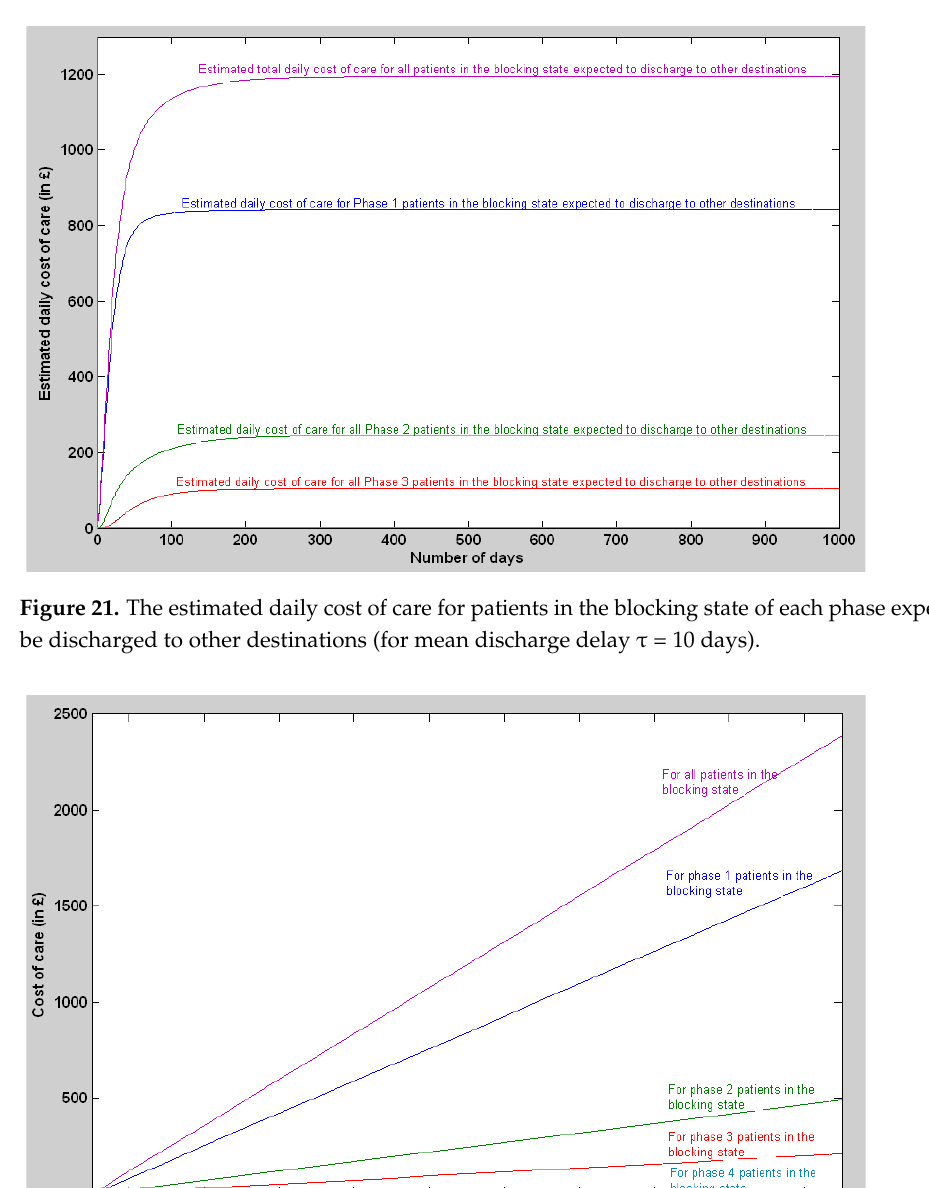
Figure 20. The estimated number of patients (with respect to discharge delay) in the blocking state for discharge to other destinations.